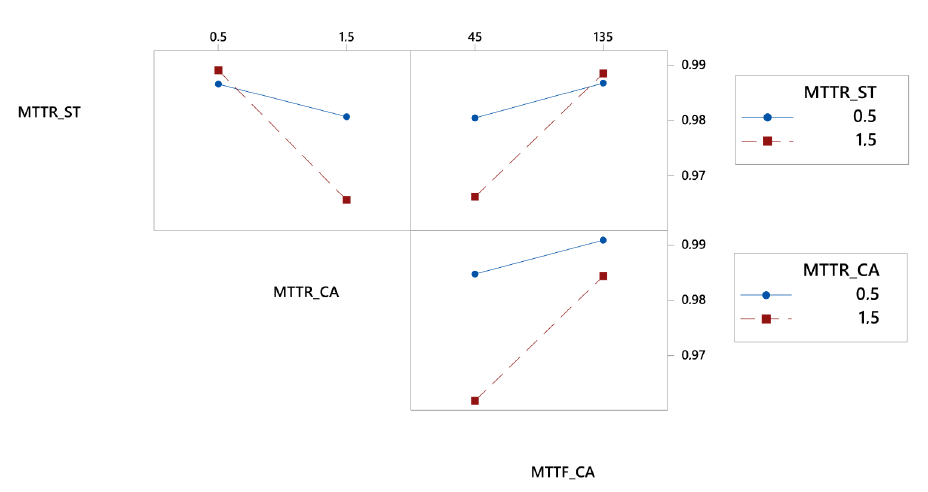
Figure 8. Factor interactions for availability.